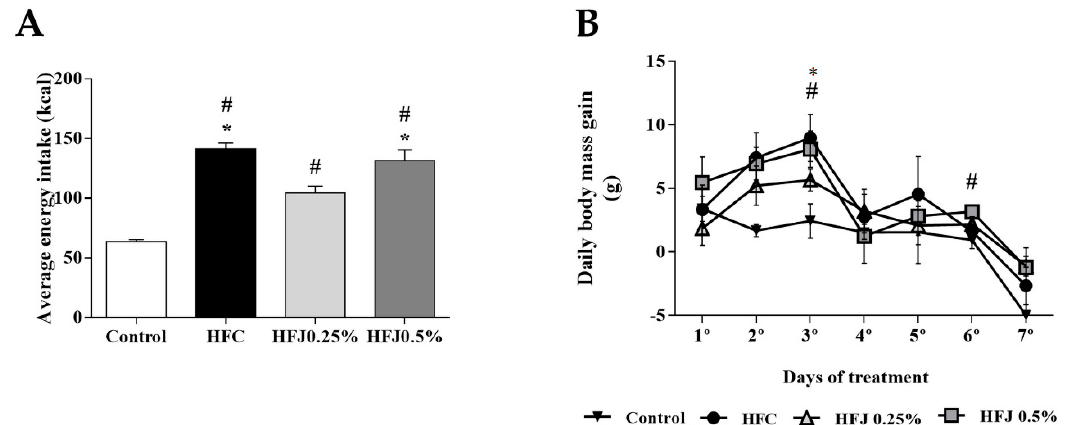
Figure 1. ( A ) Average energy intake (kcal). * p < 0.05 compared with the high-fat juçara 0.25% group (HFJ0.25%); # p < 0.05 compared with control diet by two-way ANOVA followed by the Bonferroni post-hoc test. ( B ) Daily body weight gain during the experimental period of seven days. The comparisons were performed by ANOVA for repeated measure and the Bonferroni post hoc test.